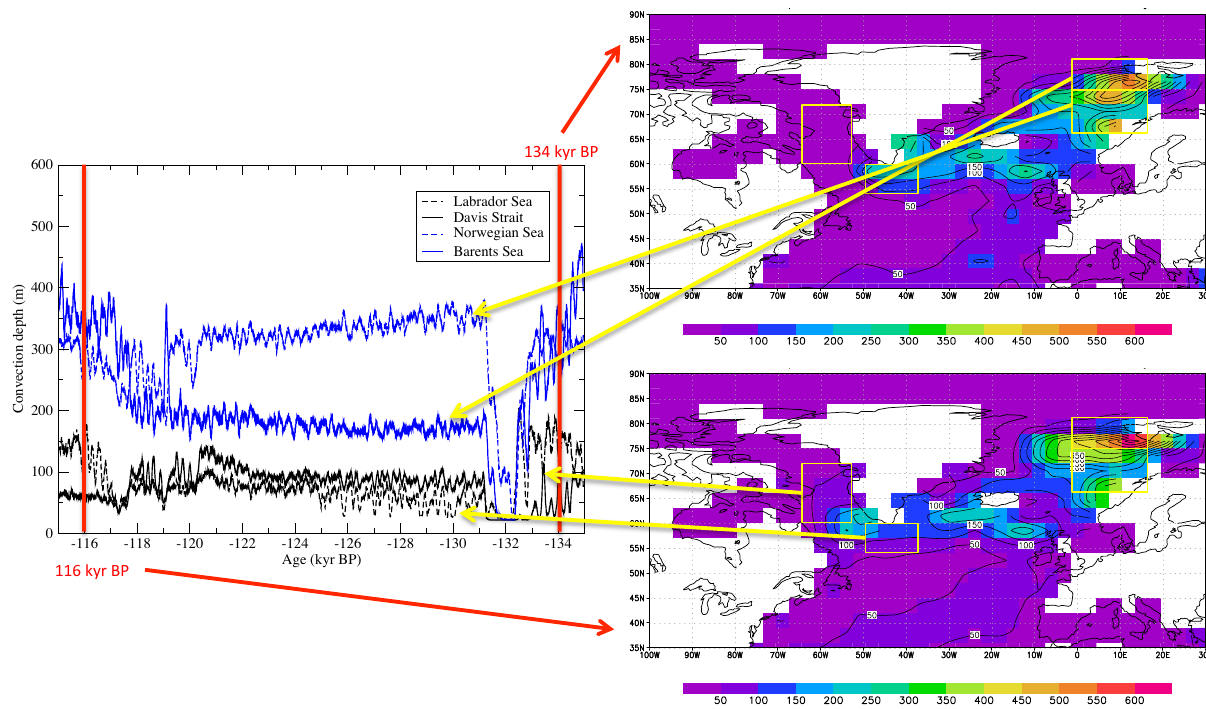
Figure 5. Winter (DJF) convection depth (m) simulated with allGR. (left) time evolution for four sites of the North Atlantic: Labrador Sea (black dashed line), Davis Strait (black full line), Norwegian Sea (blue dashed line) and Barents Sea (blue full line). These sites are identified with boxes on the right hand side of the figure. (right) convection depth (m) for the North Atlantic at 134 (top) and 116kyrBP